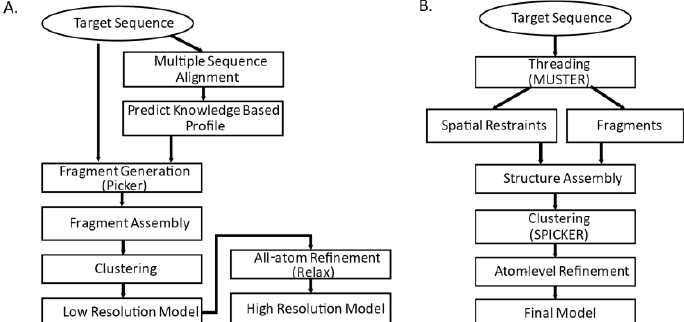
Figure 3. Structure prediction pipeline ( A ) Rosetta [54]; and ( B ) I-TASSER pipeline (adapted from Figure 1 of